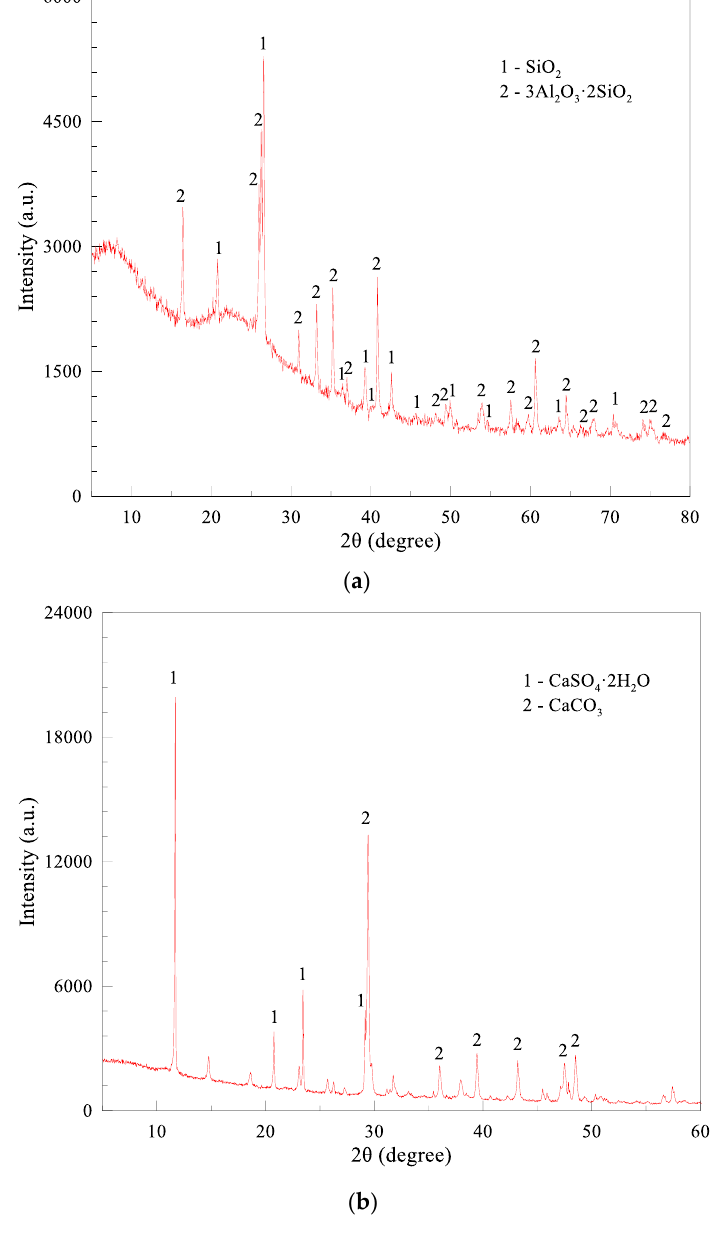
Figure 1. X-ray diffraction curves of solid wastes: ( a ) FA and ( b ) ASR. Table 1. Chemical compositions of ASR and FA (wt.%).